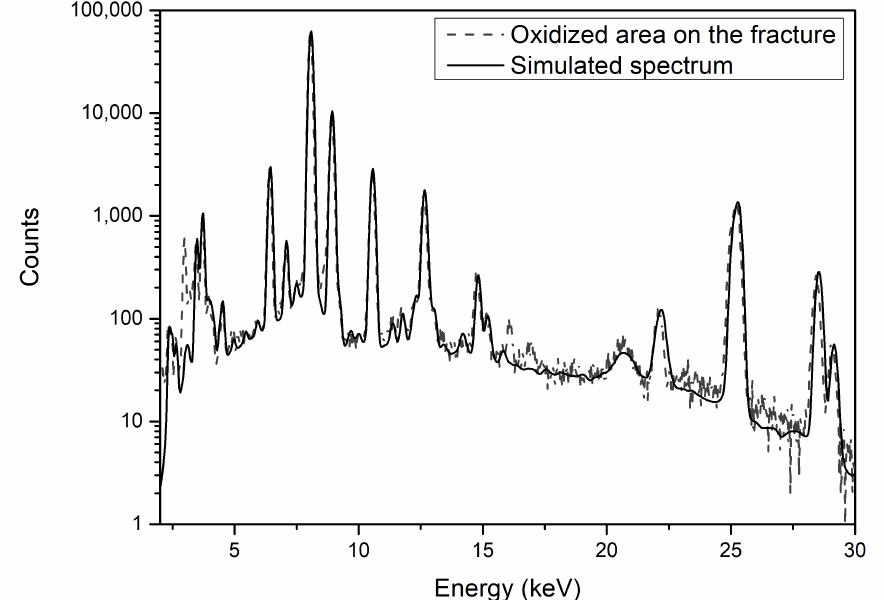
Figure 5. XRF spectrum of sample #10712’s oxidized area on the fracture (dashed line) and MC simulation (solid line).